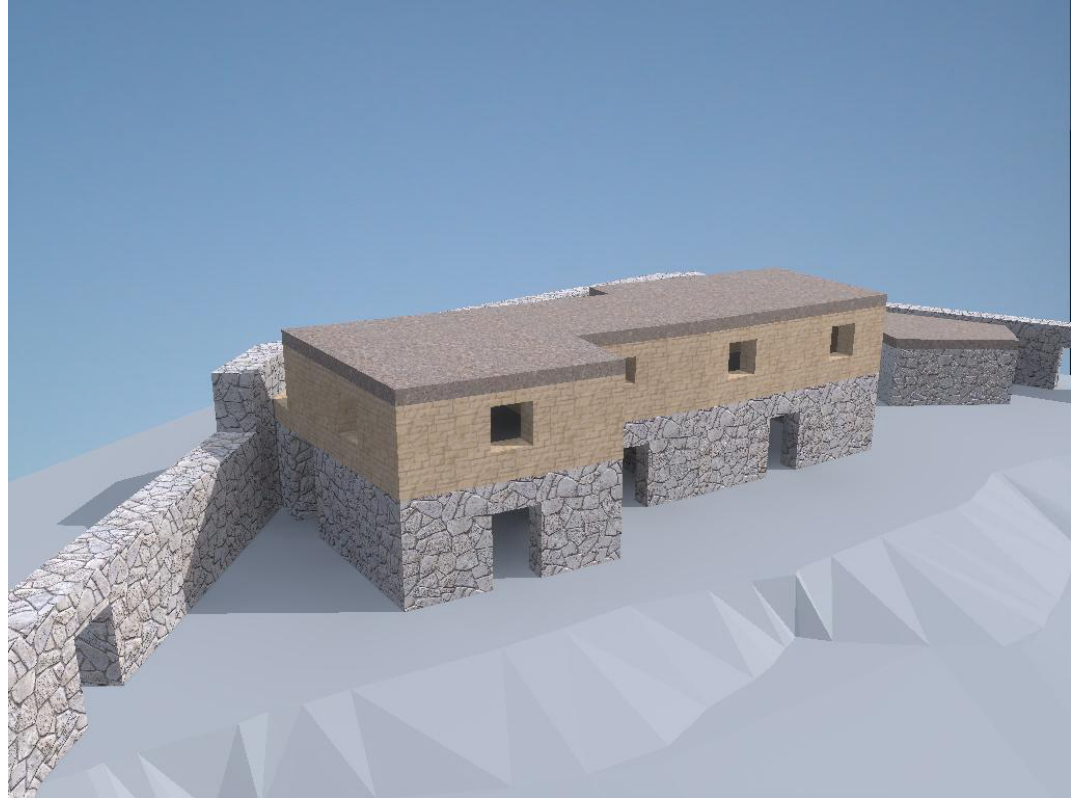
Figure 9. Agios Antonios Chomatas Site 9: ideal 3D reconstruction of the site